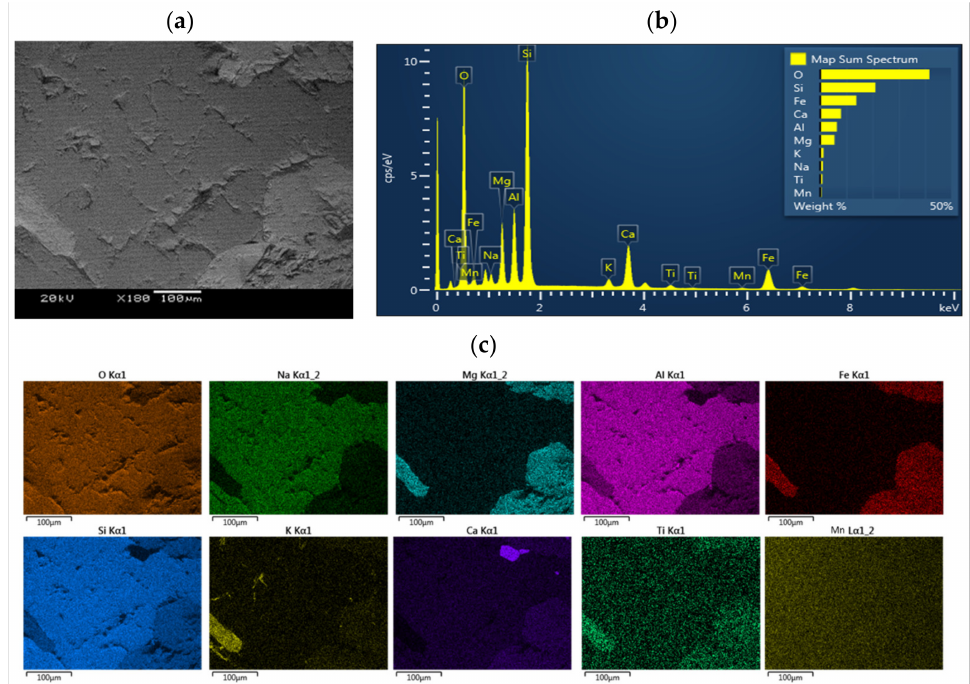
Figure 2. The SEM photos in granite and the EDS mapping of surface of granite obtained at 10 µ m spatial resolution. ( a ) SEM ( b ) EDS spectrum ( c ) elemental